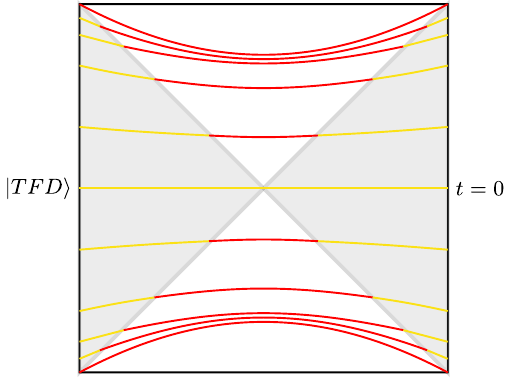
Fig. 8 The dark red surfaces are the maximal spacelike slices foliating the diagram behind the horizon and representing the